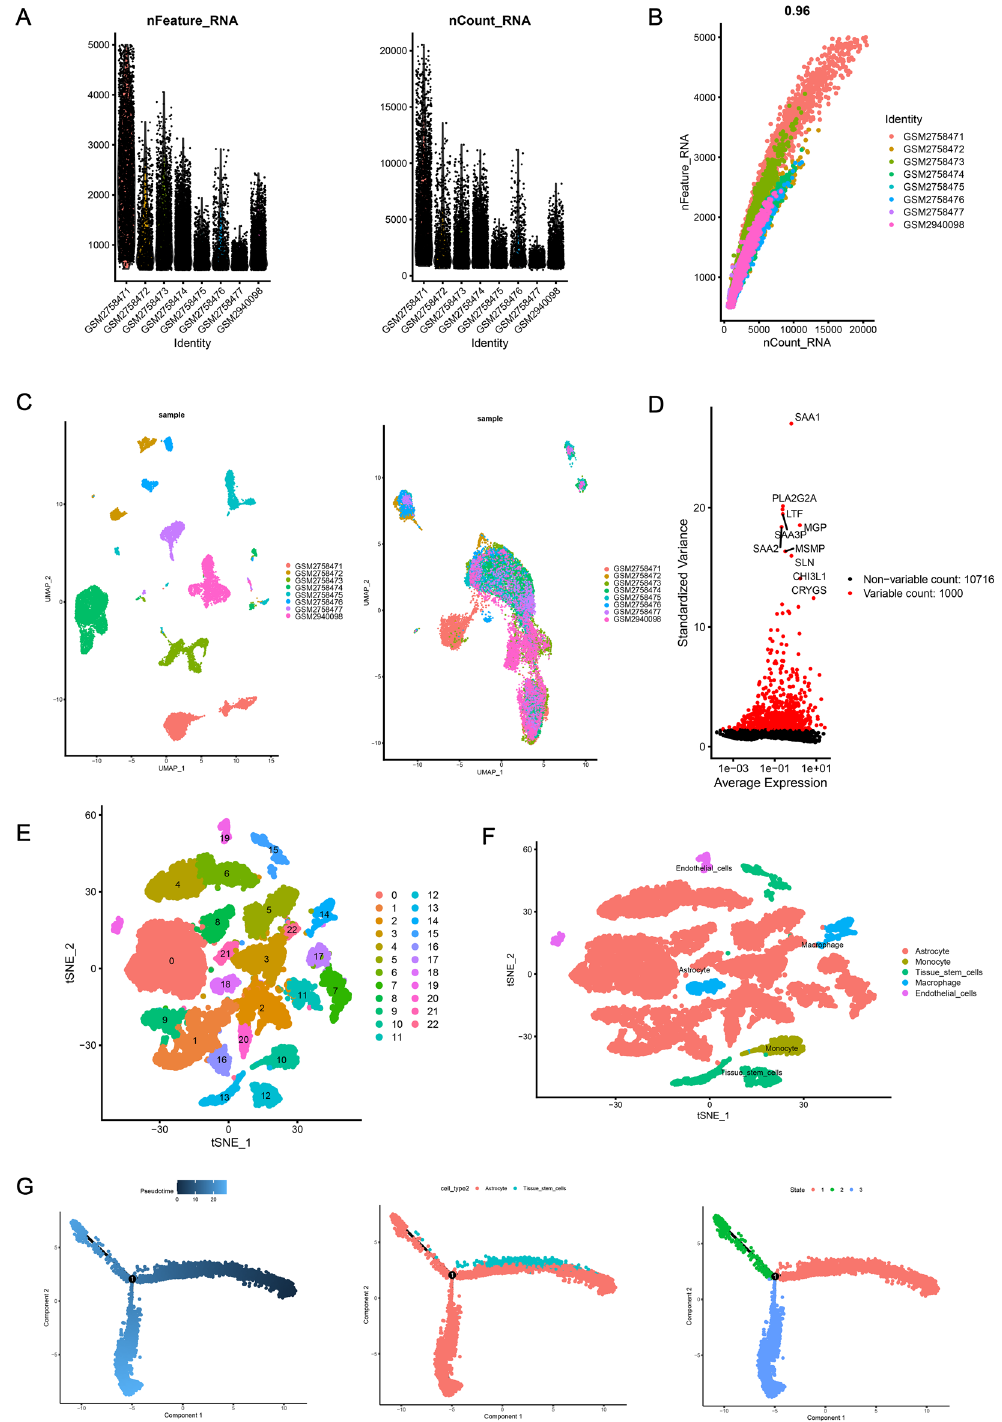
Figure 1. Clustering and differentiation trajectory analysis for cells based on single-cell RNA-seq data. ( A ) Violin plot displaying the result of quality control and fitration of the scRNA-seq dada. ( B ) Scatter plot showing the correlation between sequencing depth and the number of detected genes. ( C ) UMAP analysis showing the result of batch effect correction in which the left panel represented the result before batch effect correction and the right panel represented the result after batch effect correction. ( D ) Scatter plot showing 1000 highly variable genes across the total samples with top 10 genes annotated. ( E ) Scatter plot showing 23 cell clusters processed by the tSNE algorithm based on 10 PCs. ( F ) Scatter plot showing the cells annotated with cell types. ( G ) Differentiation trajectory analysis identifying 3 branches of astrocyte and tissue stem cells with distinct differentiation state and pseudotime. UMAP: Uniform Manifold Approximation and Projection, PCA: principal component analysis, tSNE: t-distributed stochastic neighbor